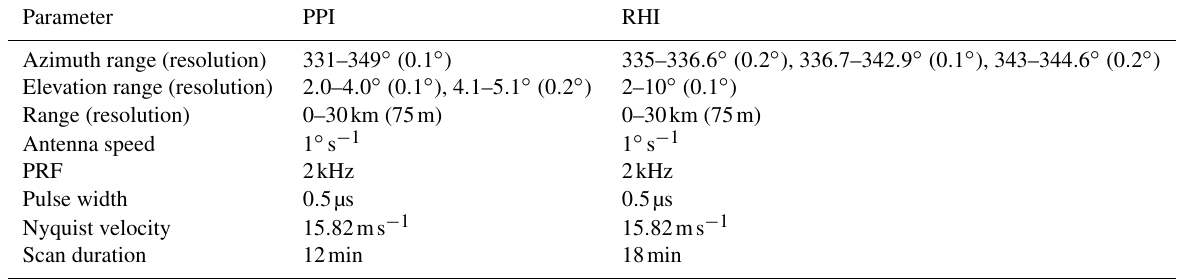
Table 3. Scanning parameters of the mobile weather radar used for the wind turbine measurement campaign in 2019. The solar scan param- eters are not included.